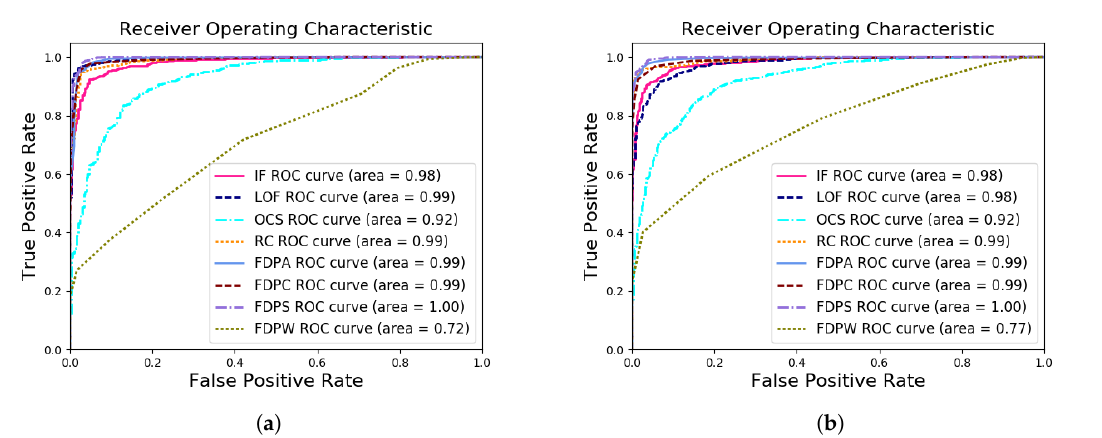
Figure 11. The ROC curves and AUC values for the real-world dataset with ( a ) 300 and ( b ) 600 outliers.